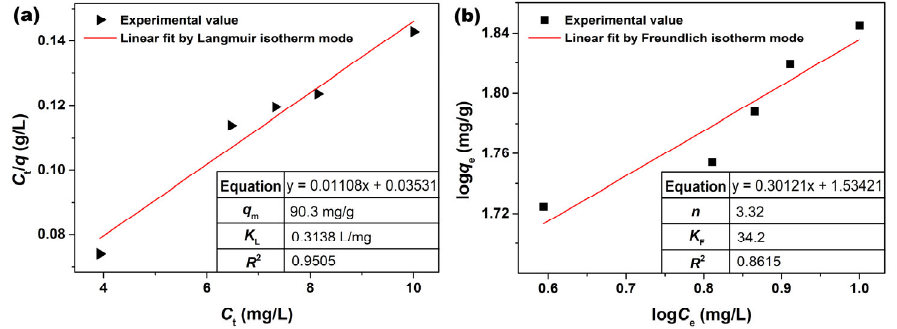
Figure 8. ( a ) Langmuir and ( b ) Freundlich linear fits of AO7 adsorbed onto porous CeO 2 adsorbent hydrothermally synthesized at 200 °C for 24 h with 4 mmol guanidine carbonate and 4 mL 30% H 2 O 2 ([CeO 2 ] = 2.0 g/L; [AO7] = 110~150 mg/L; V = 100 mL; t = 60 min; 200 rpm; Room temperature; No pH preadjustment). Table 1. Recent literature on adsorbents for the removal of AO7 dye.